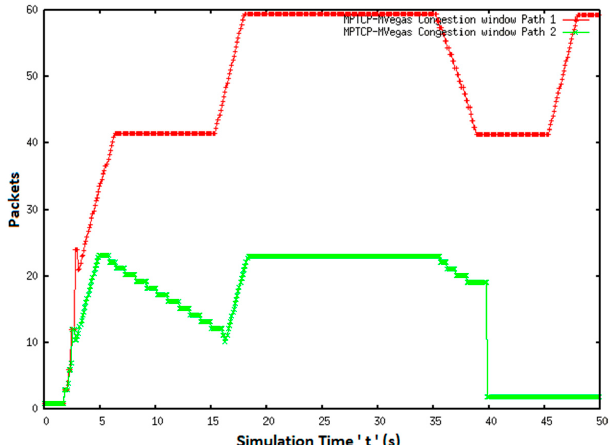
Figure 8. Congestion windows of individual subflows belonging to MPTCP modified TCP Vegas (MPTCP-MVegas).